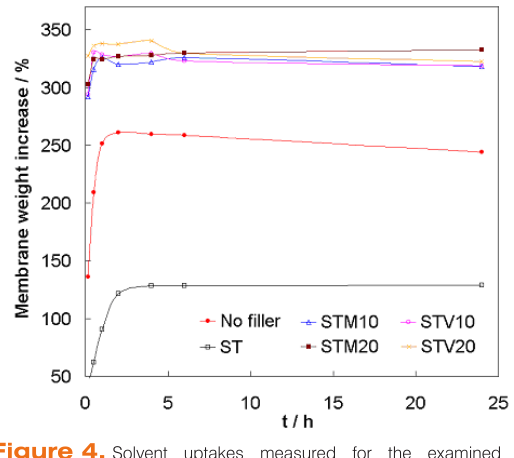
Figure 4. Solvent uptakes measured for the examined dry membranes as a function of time immersed in the liquid Table 1. Acronyms and basic description of the synthesized ceramic fillers Filler